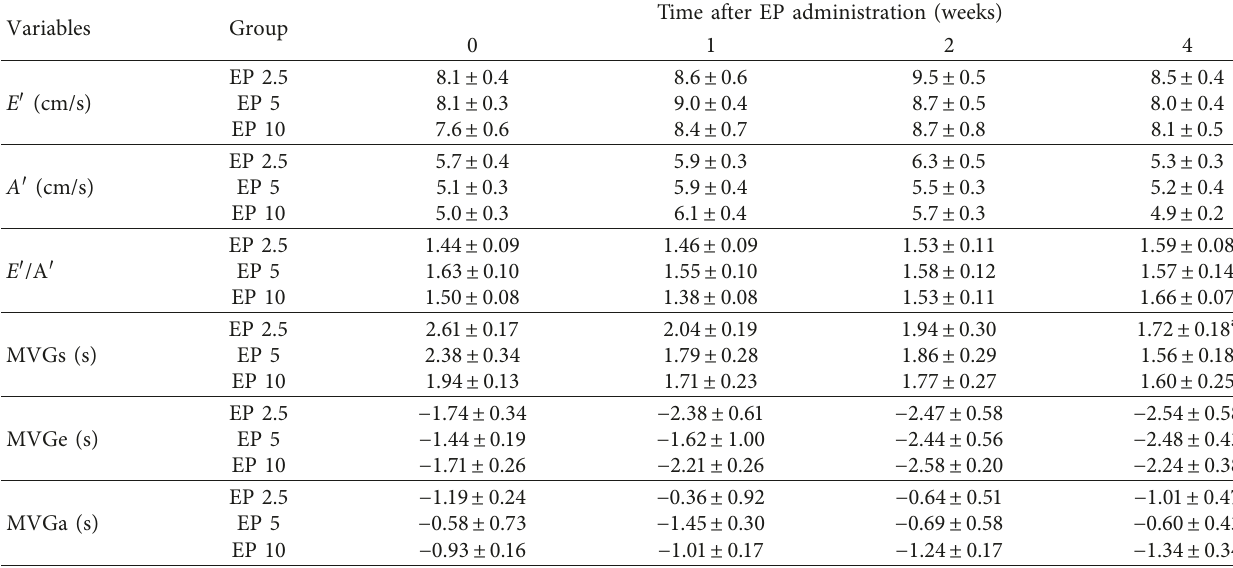
Table 2: Peak velocity of early diastolic septal mitral annular motion ( E ′ ), peak velocity of diastolic septal mitral annular motion ( A ′ ), ratio of the peak velocity of early diastolic mitral annular motion to the peak velocity of diastolic mitral annular motion ( E ′ / A ′ ), mid systolic myocardial velocity gradient (MVGs), early diastolic myocardial velocity gradient (MVGe), and atrial systolic myocardial velocity gradient (MVGa) after eplerenone (EP) administration in dogs.